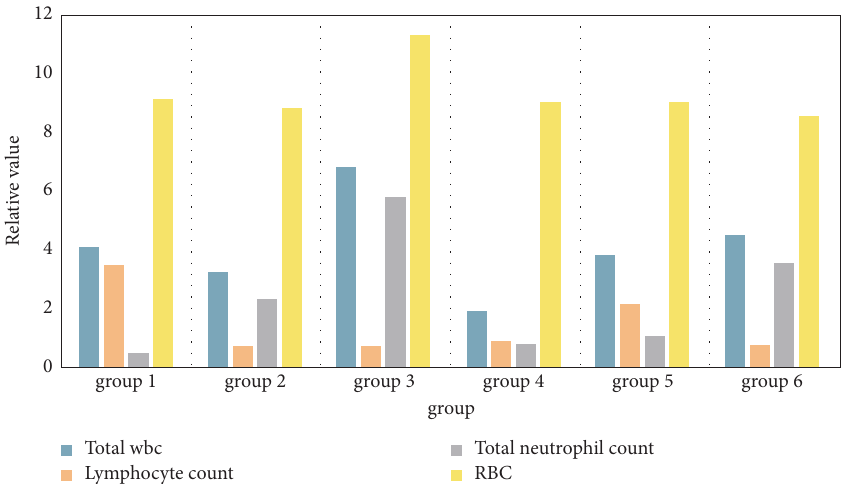
Figure 10: Analysis of blood routine examination in diferent groups of nude mice. WBC � white blood cell; LYM � lymphocyte amount; GRAN � granulocyte; RBC � red blood cell. Table 3: Biochemical results of nude mice in each group.